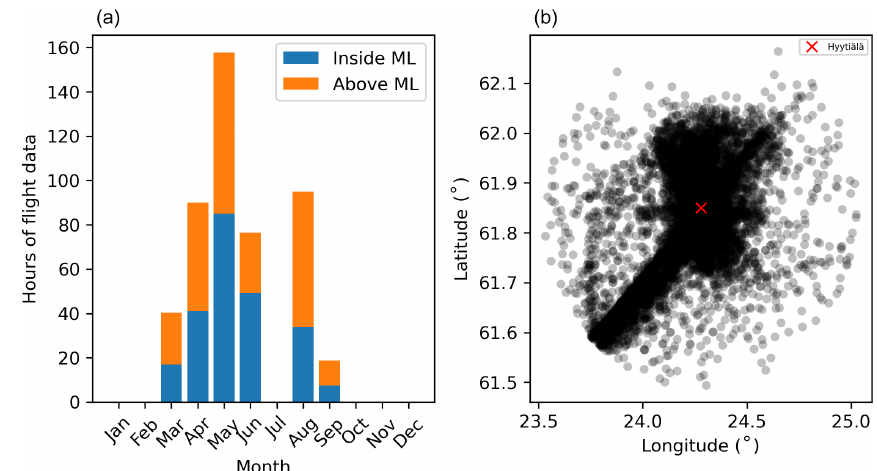
Figure 1. (a) Monthly airborne data availability between 2011–2018 divided into measurements above and below the ML based on the ML height obtained from the ERA5 reanalysis data. (b) Horizontal distribution of the 2011–2018 airborne measurement data. We chose the data within a 40km radius from Hyytiälä.